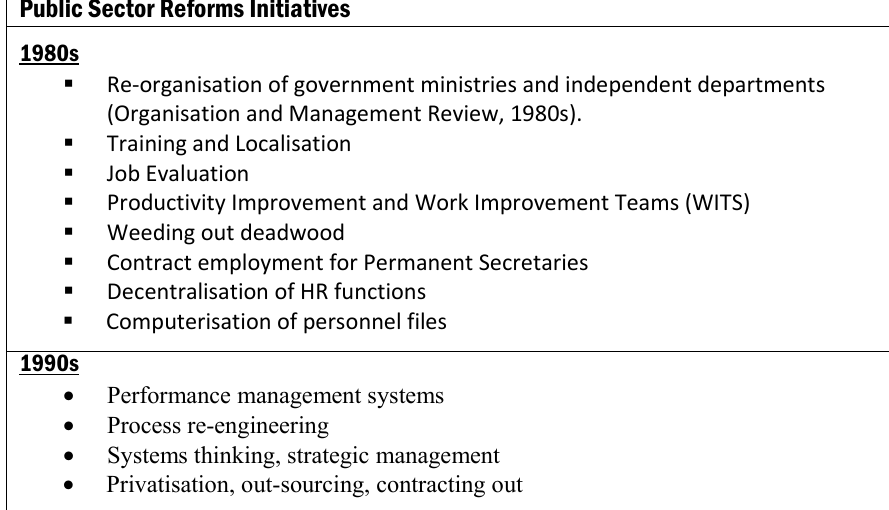
Table 3: Evolution of Public Service in Botswana Public Sector Reforms